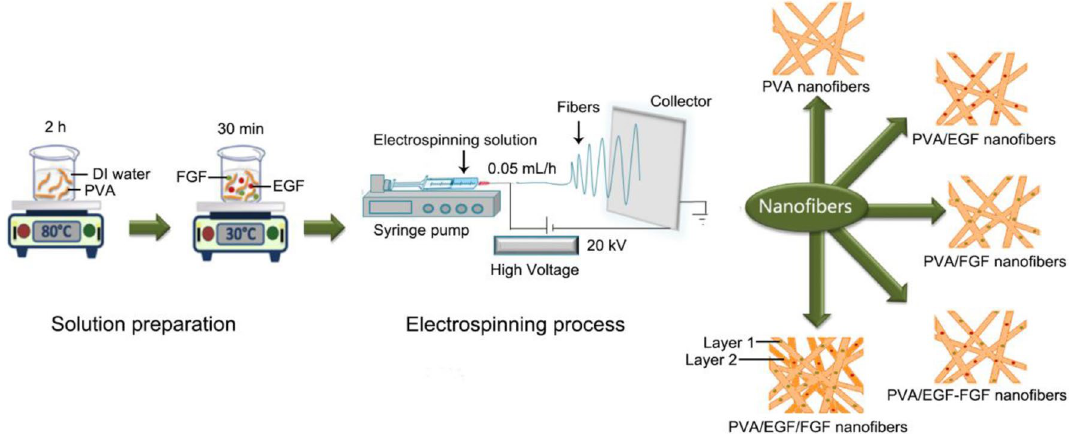
Figure 1. Schematic diagram of electrospun nanofibers